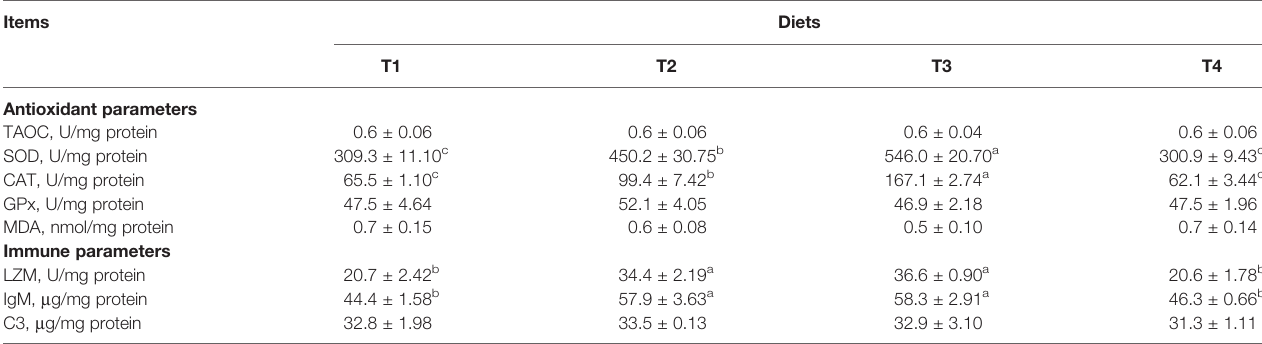
TABLE 3 | Liver antioxidant and immune parameters of L. maculatus fed experimental diets.